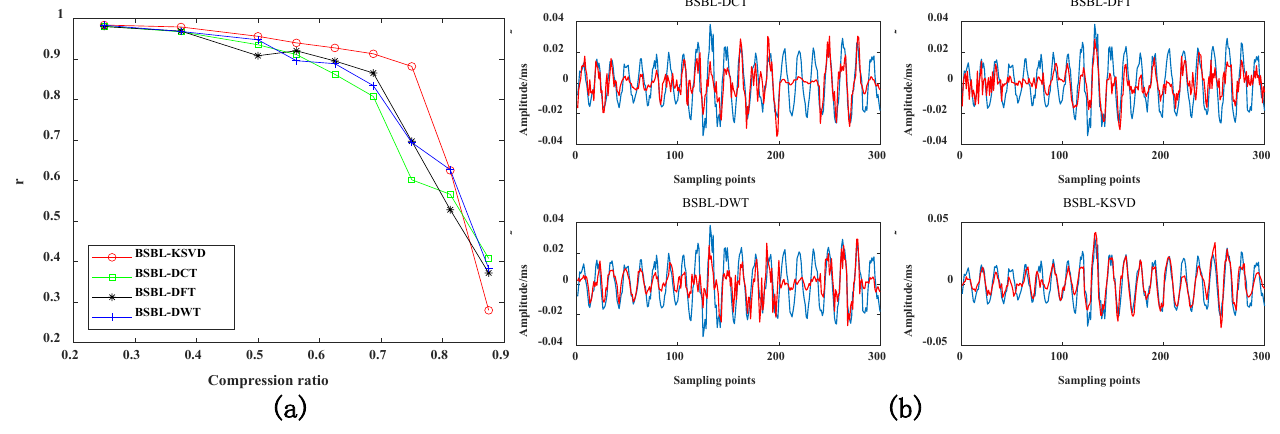
Figure 10. ( a ) Comparison of r indicators of different sparse dictionaries; ( b ) when CR = 0.6, the reconstruction signal comparison of different dictionaries.